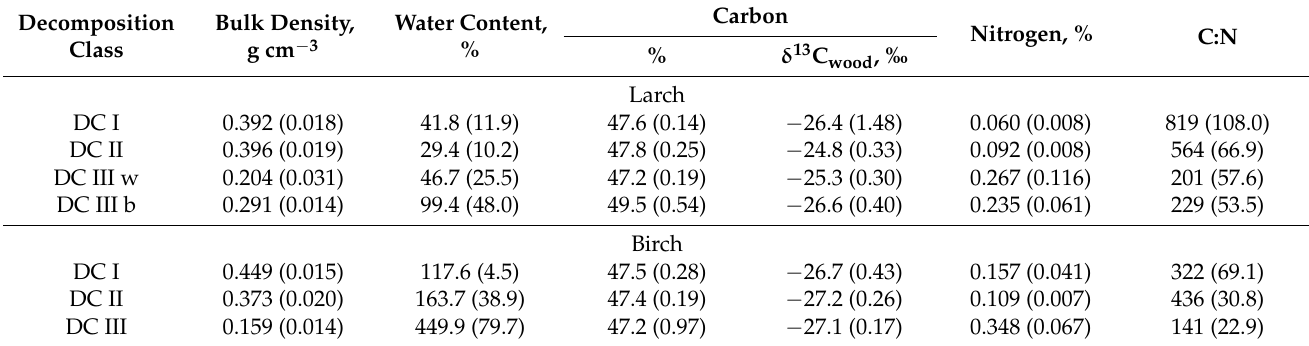
Table 1. The main characteristics of the coarse woody debris samples used in the experiment.